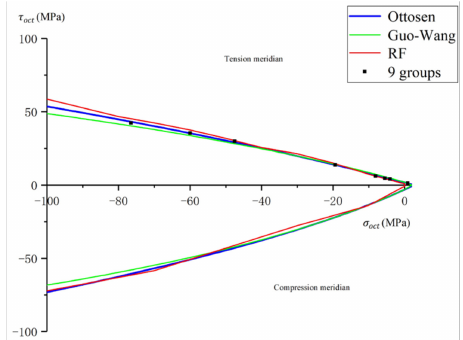
Figure 15. Tension and compression meridian.